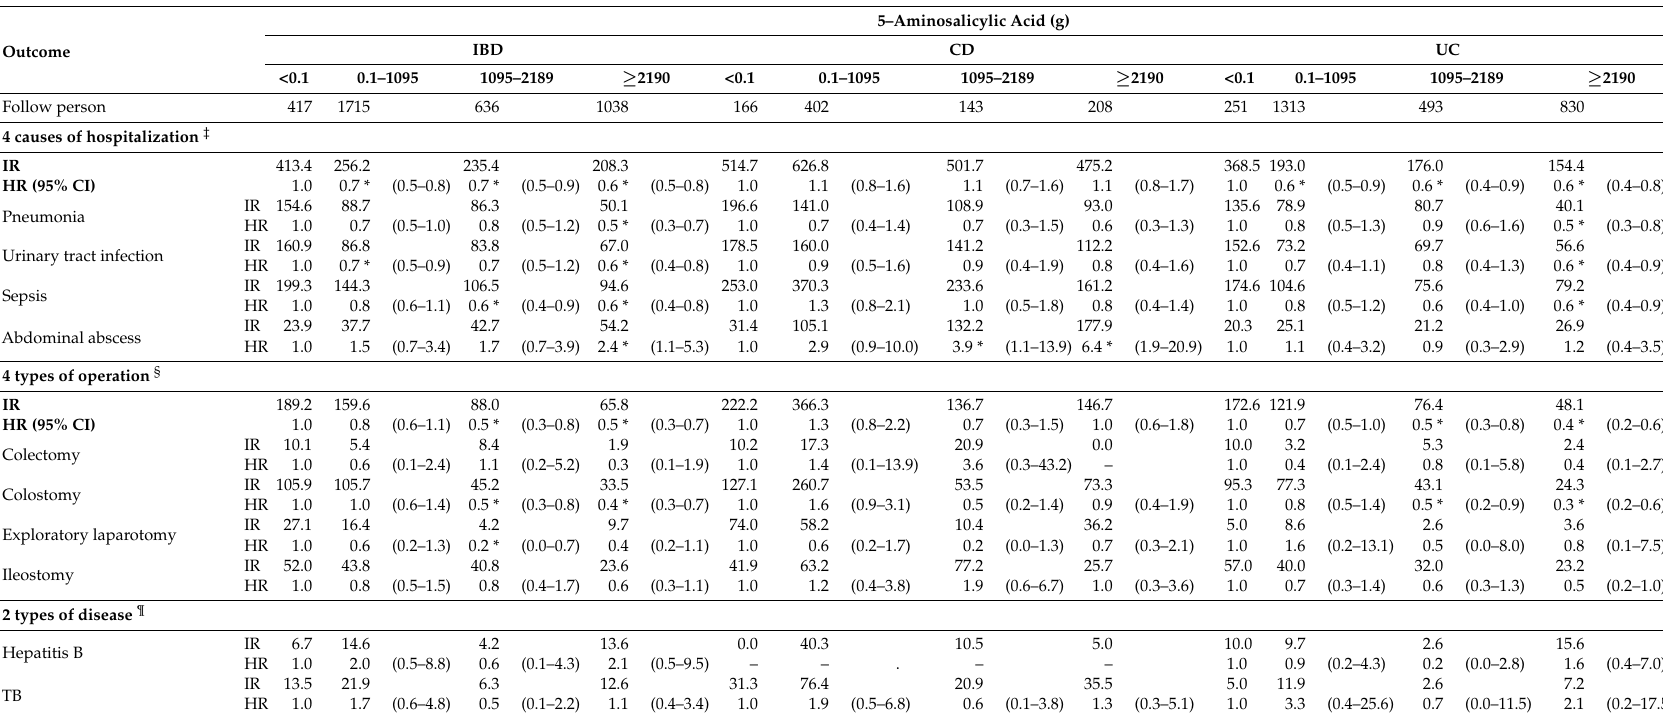
Table 2. Risks of operation, hospitalization, and related diseases associated with 5-aminosalicylic acid therapy among patients with IBD in Taiwan, 2001–2015.